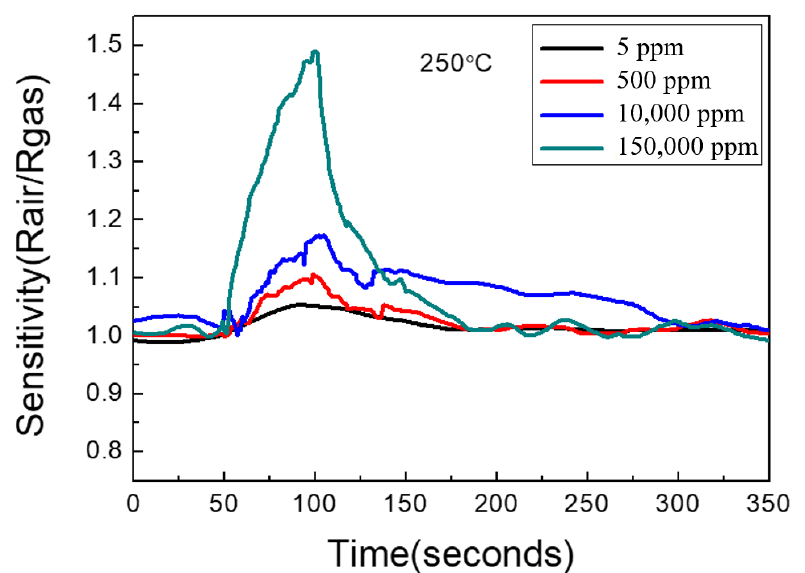
Figure 7. Sensitivity measurements of graphene/zinc oxide nano-heterostructures to different H 2 concentrations at 250 °C.